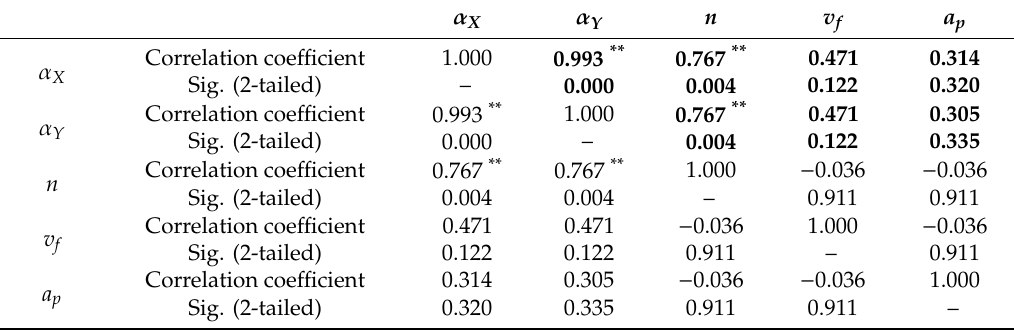
Table 2. Correlation between acceleration vibration and milling